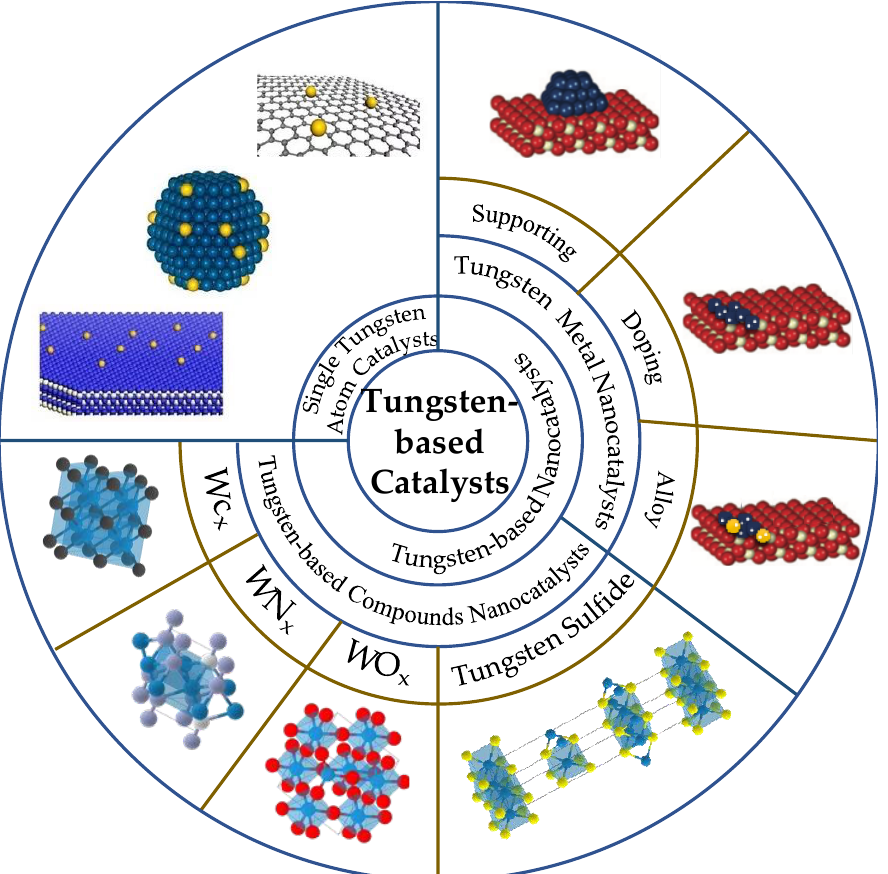
Figure 4. Learning direction of this paper.